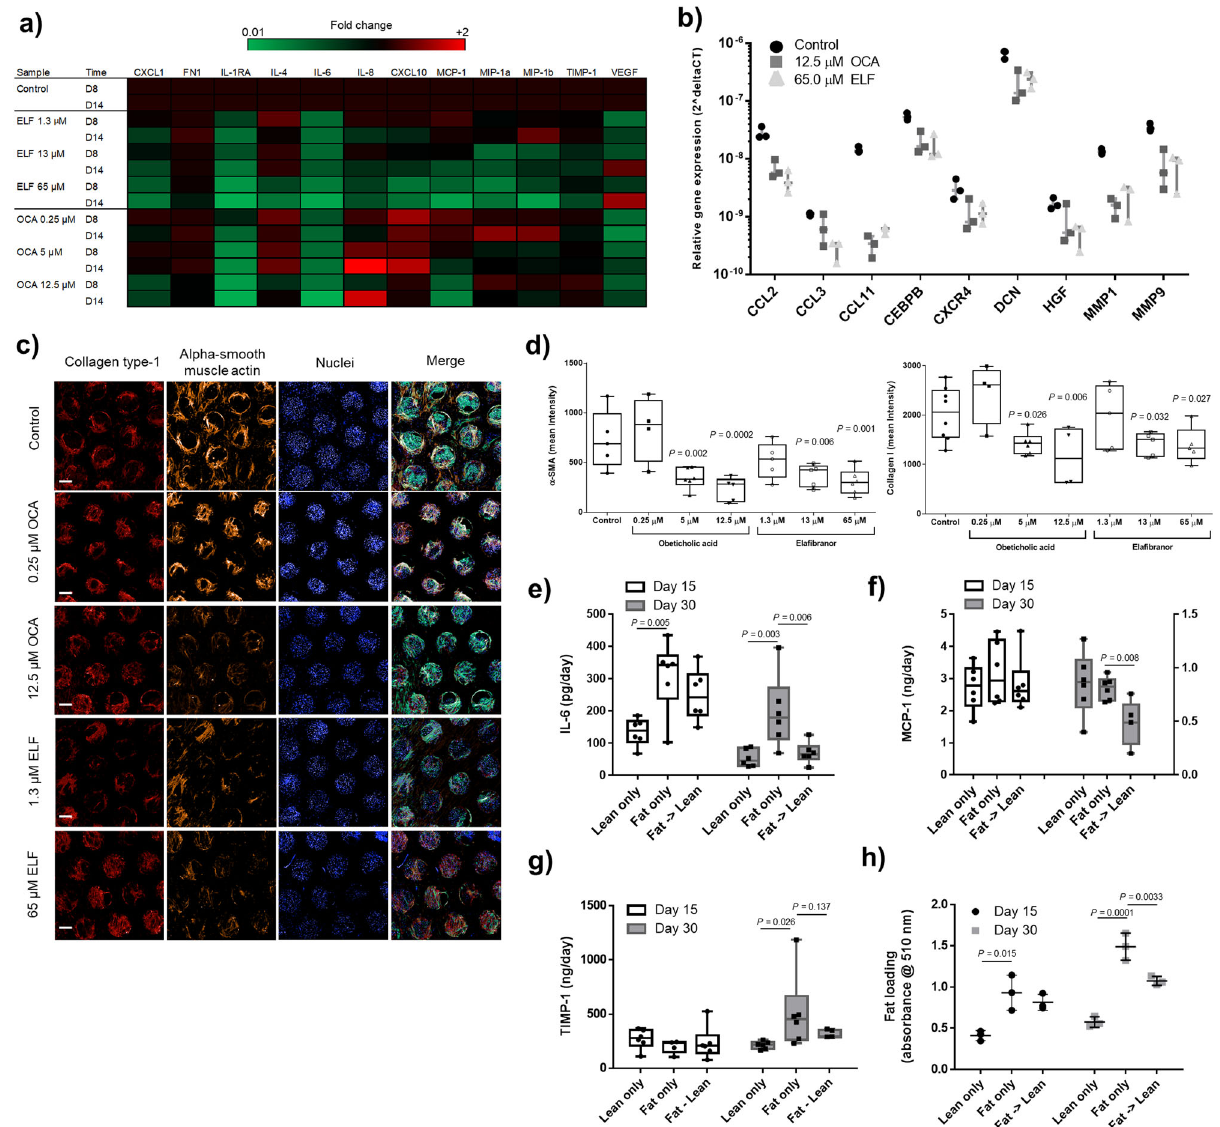
Fig. 3 Obeticholic acid and Ela fi branor both modulate in fl ammatory and fi brosis phenotype in liver MPS NASH model and phenotype can additionally be reversed with dietary changes. PHH, KC and HSC co-cultures were cultured in the MPS platform under high fat conditions and dosed with varying concentrations of Obeticholic acid (OCA) and Ela fi branor (ELF) QD or vehicle control (control) for 10 days, following an initial 4-day pre-culture phase. a The secreted cytokine pro fi le from liver microtissues was compared by Luminex to determine the effects of each compound on the in fl ammatory pro fi le of the liver with samples analysed at day 8 and 14 of the culture. Data were normalised by Z-transformation to allow comparison of all analytes and presented as a heatmap. b The expression of fi brosis-associated genes was analysed in total RNA from control, OCA and ELF treated liver microtissues (highest concentration for each compound) using Human Fibrosis RT2 Pro fi ler PCR Arrays. Gene expression changes are expressed as a fold change over control. c Liver microtissues were stained for collagen-type I, α -SMA, nuclei (DAPI - blue), phalloidin (green) and imaged by confocal microscopy. Representative images are shown and scale bars 200 µ m. d Staining of microtissue was quanti fi ed by measuring total fl uorescence intensity throughout individual microtissues, each data point represents an average of all the microtissues imaged within an MPS scaffold (min 8, max 20 microtissues). e PHH, KC and HSC co-cultures were cultured in the MPS platform under high fat or lean conditions for 30 days. Cultures either remained in the same type of media throughout or were switched at day 15 from fat media to lean media (Fat -> Lean). Cell culture medium samples were analysed for the presence of IL-6, f MCP-1, g TIMP-1, which were measured by ELISA. h Microtissues were stained with Oil-Red O to determine fat loading during culture period, total stain was quanti fi ed by absorbance at 510 nm. All datapoints shown, either as box-whisker plots highlighting mean and min-max or with error bars highlighting means ± SD. All data from a minimum of three independent cultures; statistical comparisons made to control samples unless other comparison NAFLD in humans, namely lipid accumulation, insulin resis- steatosis in NAFLD (Supp. Fig. 9). Fructose and fat (FFA) tance, mitochondrial dysfunction and changes to the poly (ADP- challenge combined with fructose-induced differential expression ribose) polymerases (PARP) pathway. FFA and the combination changes consistent with insulin resistance 44 (Supp. Fig. 10). Most cues also reduced the expression of mitochondrial associated of FFA plus cholesterol, but not the other single cues, affected genes (Supp. Fig. 11) and challenge with FFA was suf fi cient to lipid droplet-associated genes 43 in a manner resembling simple